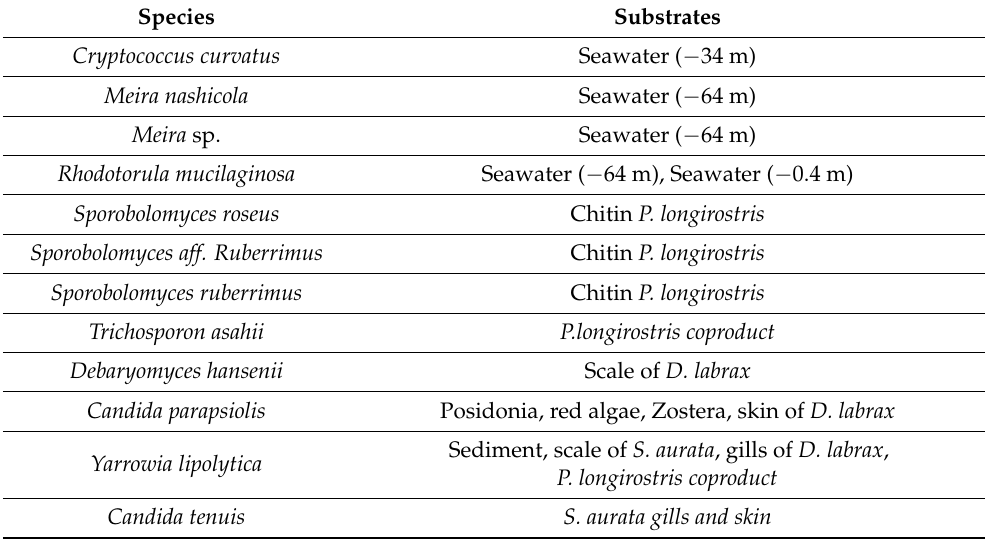
Table 3. Molecular identification of marine